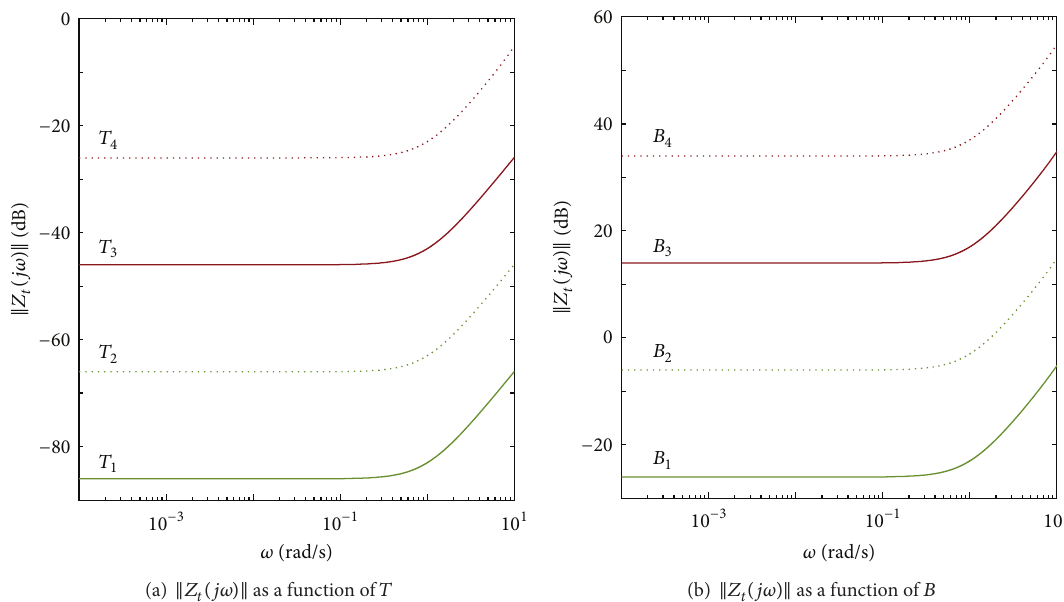
Figure 3: Bode magnitude plot of transmitted impedance 𝑍 𝑡 (𝑠) for the free motion case. (a) ‖𝑍 𝑡 (𝑗𝜔)‖ plotted for different delays when (𝑗𝜔)‖ plotted for different wave impedances when 𝑇 = 0.1 [ s ] is fixed. 𝐵 = 1 [ N ⋅ m / s ] is fixed. (b) ‖𝑍 𝑡